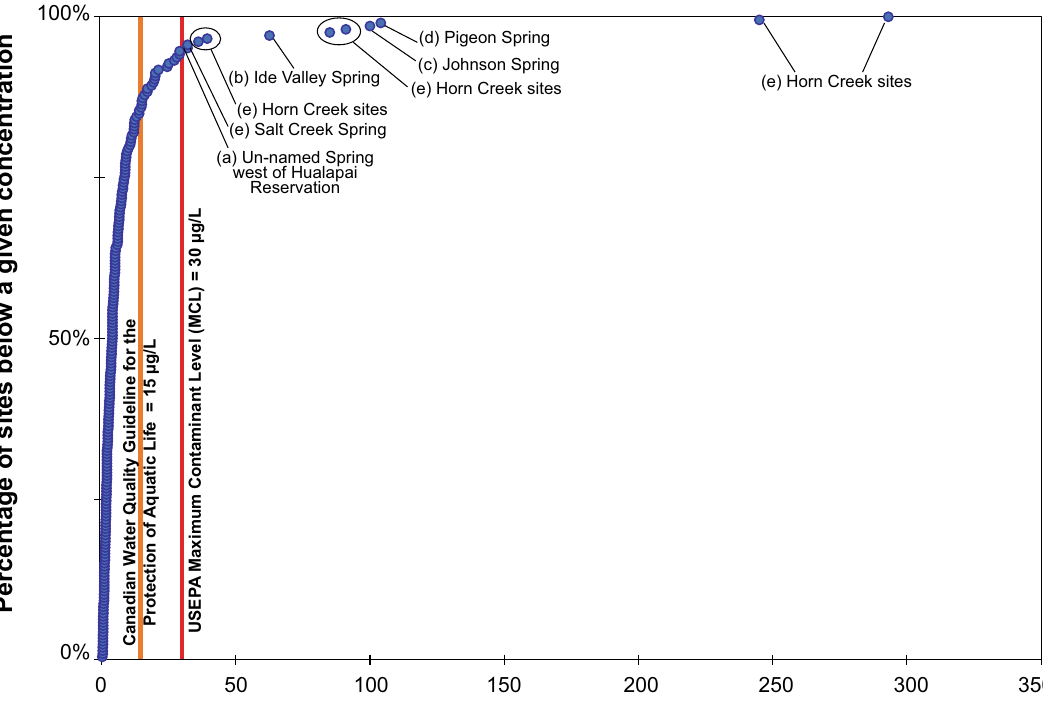
Figure 4. Distribution of the maximum concentration of uranium in groundwater samples from 206 sites in the Grand Canyon region. Letters indicate sites in Fig. 3 and are further discussed in the